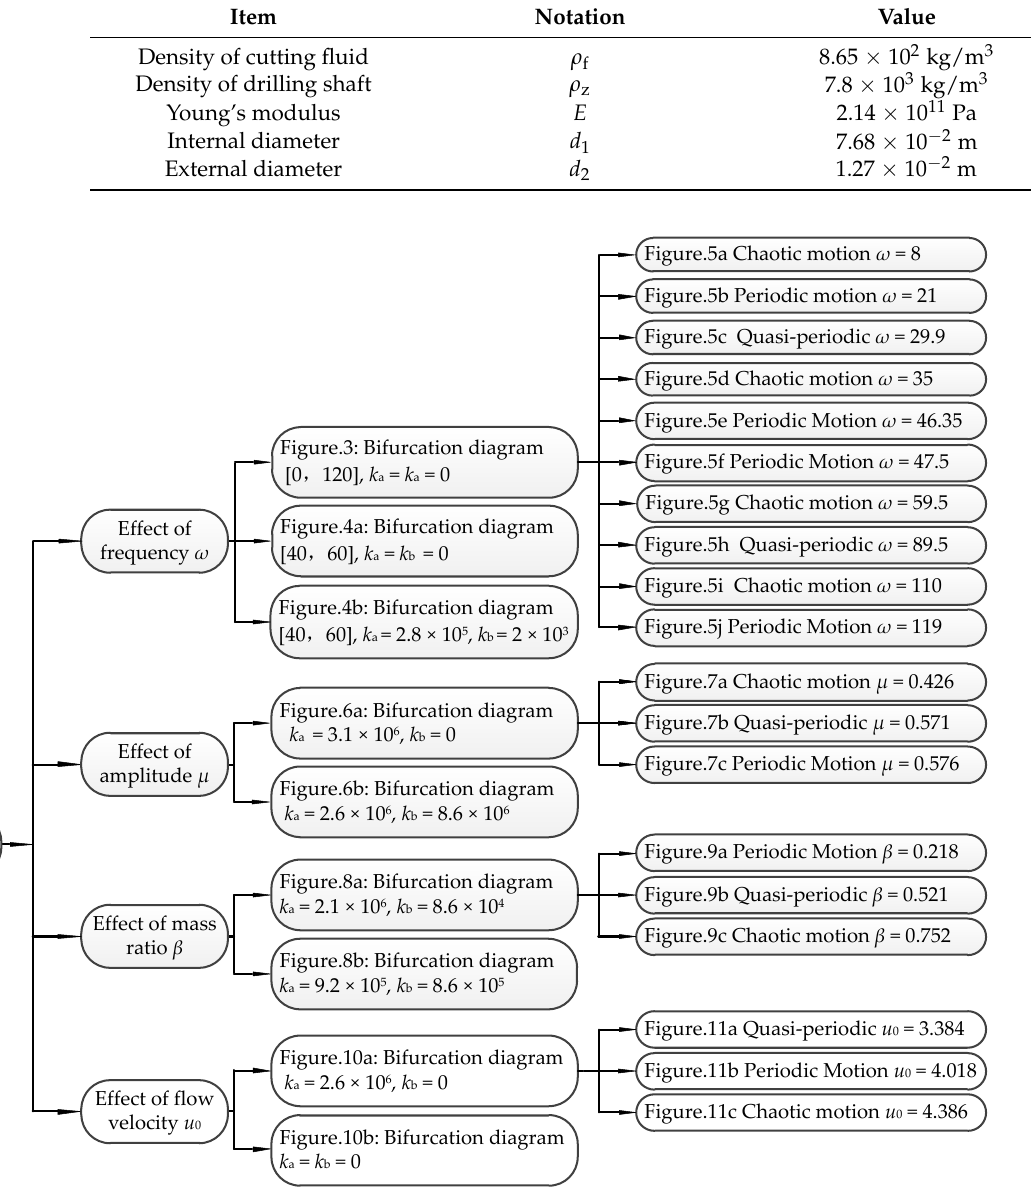
Figure.3: Bifurcation diagram Figure.4a: Bifurcation diagram Figure.4b: Bifurcation diagram Figure.6a: Bifurcation diagram k a = 3.1 × 10 6 , k b = 0 Figure.6b: Bifurcation diagram k a = 2.6 × 10 6 , k b = 8.6 × 10 6 Figure.8a: Bifurcation diagram k a = 2.1 × 10 6 , k b = 8.6 × 10 4 Figure.8b: Bifurcation diagram k a = 9.2 × 10 5 , k b = 8.6 × 10 5 Figure.10a: Bifurcation diagram k a = 2.6 × 10 6 , k b = 0 Figure.10b: Bifurcation diagram k a = k b = 0 Figure 2. Simulation condition schematic. Figure 2. Simulation condition